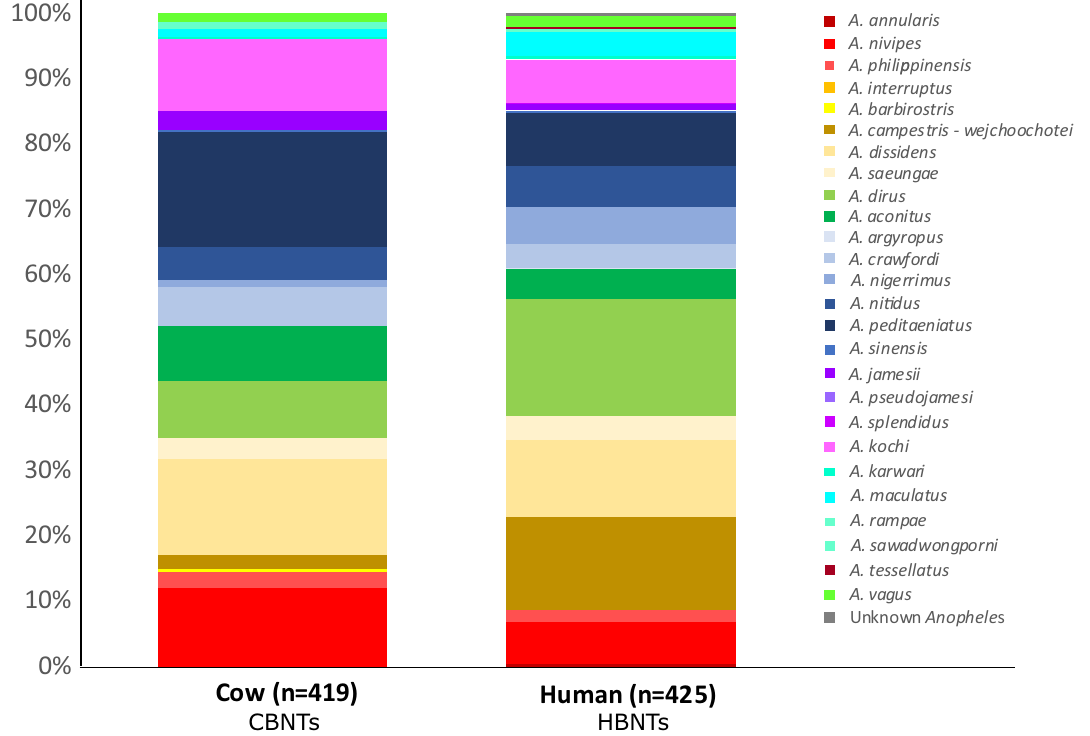
Figure 5. Proportions of the molecularly identified samples in the CBNTS and